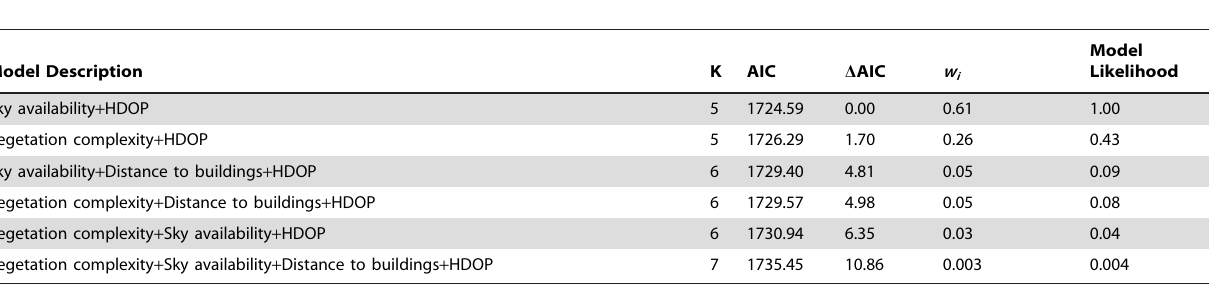
Table 4. Ranking of models explaining the location error (LE) obtained by lightweight GPS collars in different suburban habitat types and sky availability classes during stationary collar tests (n=36), Dunedin, New